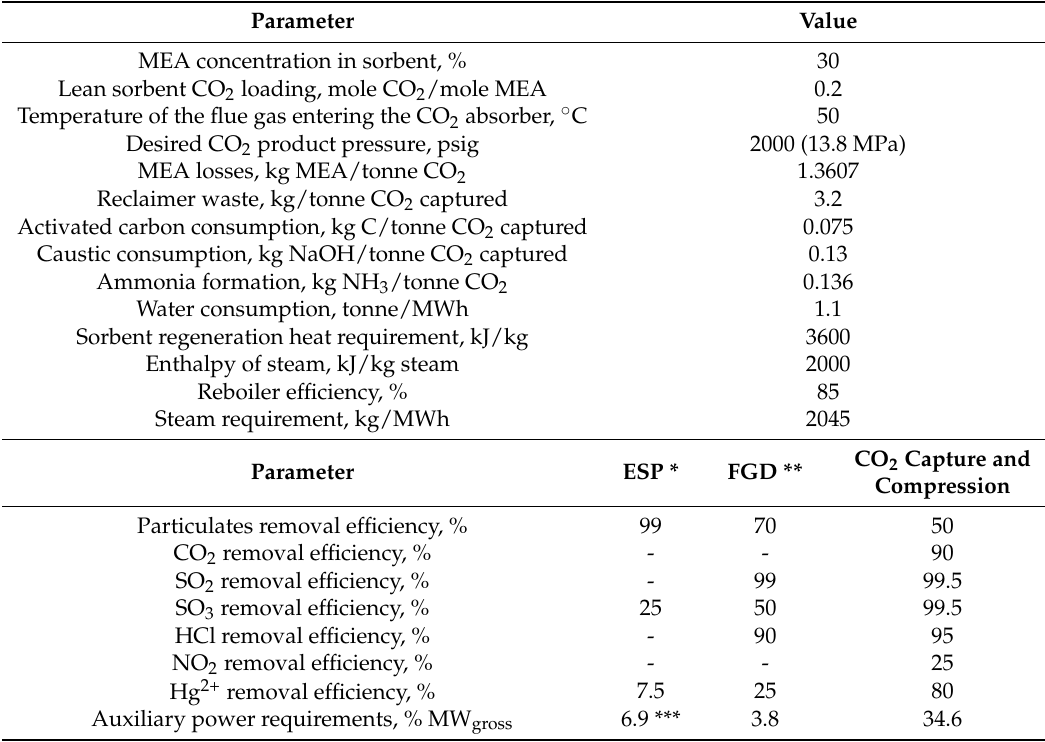
Table 7. Model assumptions of the conventional lignite coal-fire electricity generation with and without post-combustion CO 2 capture process